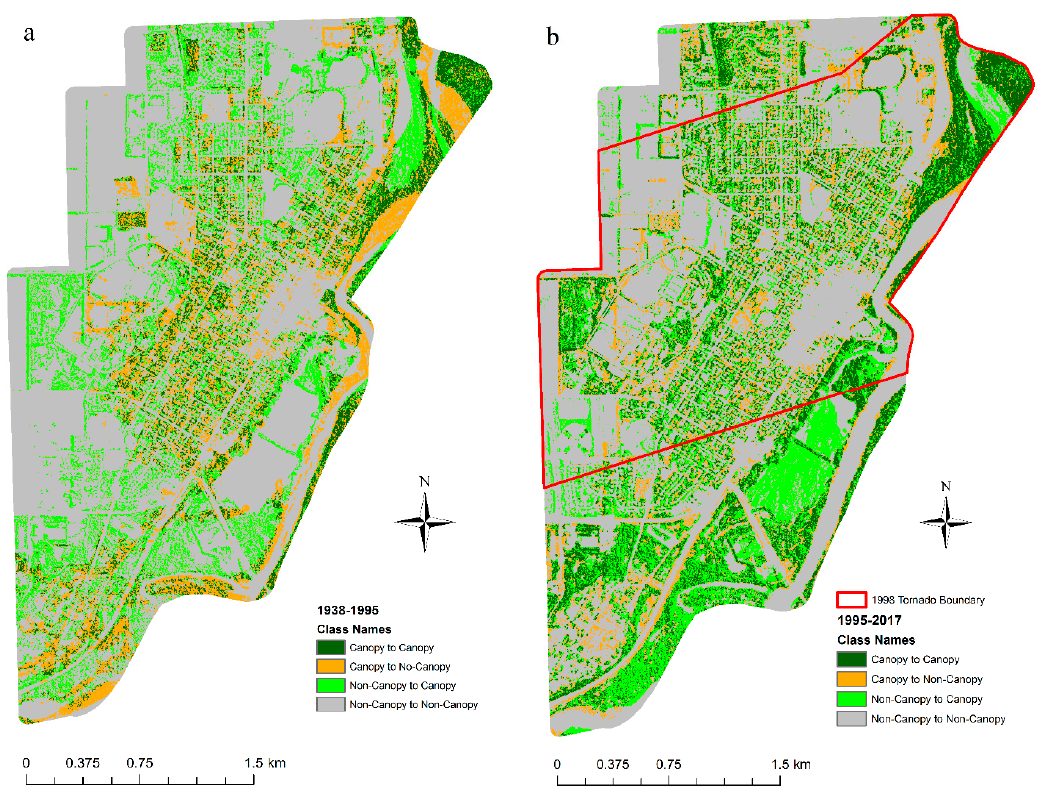
Figure 4. OBIA-based urban tree canopy change from 1938 to 1995 ( a ) and canopy change from 1995 to 2017 ( b ) within the City of St Peter.